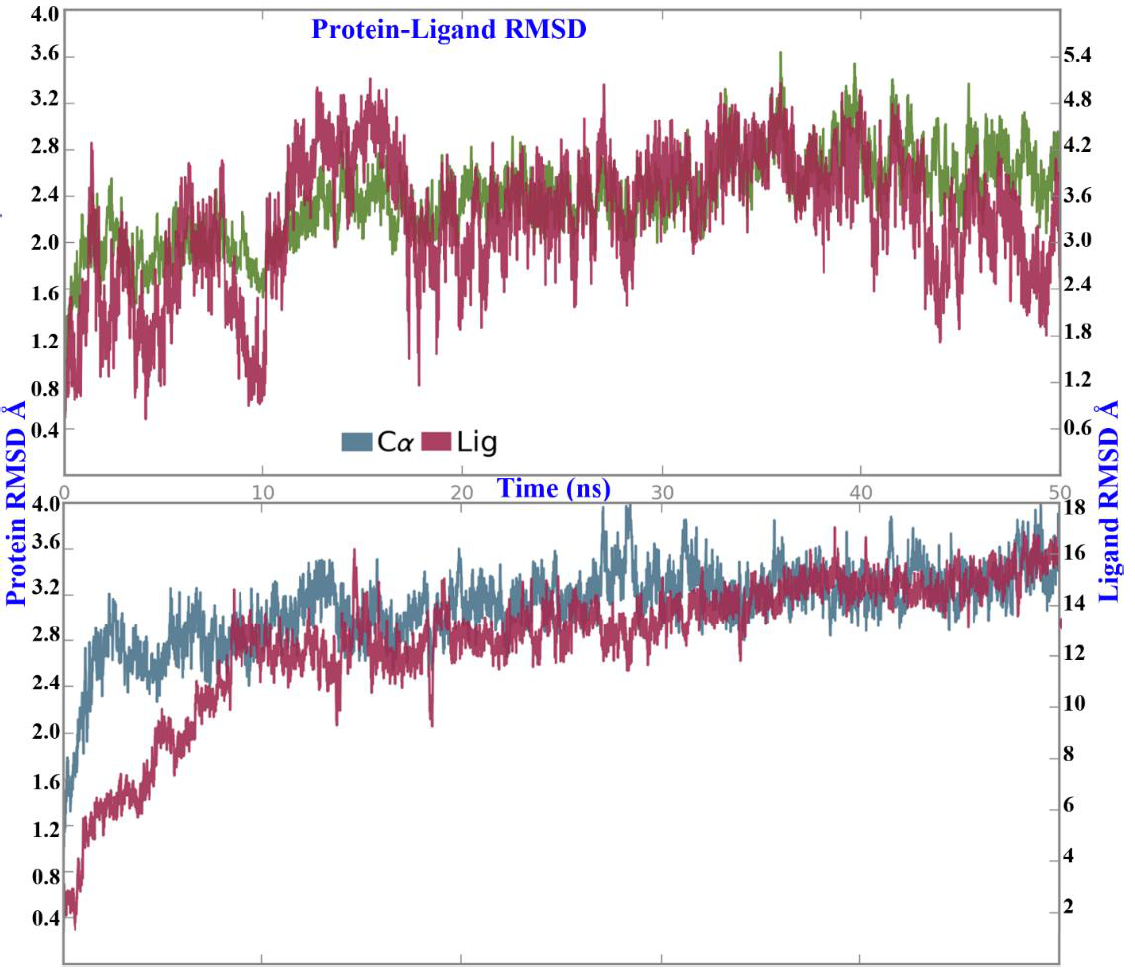
Figure 5. The RMSD of protein and ligand over the MD simulation time.